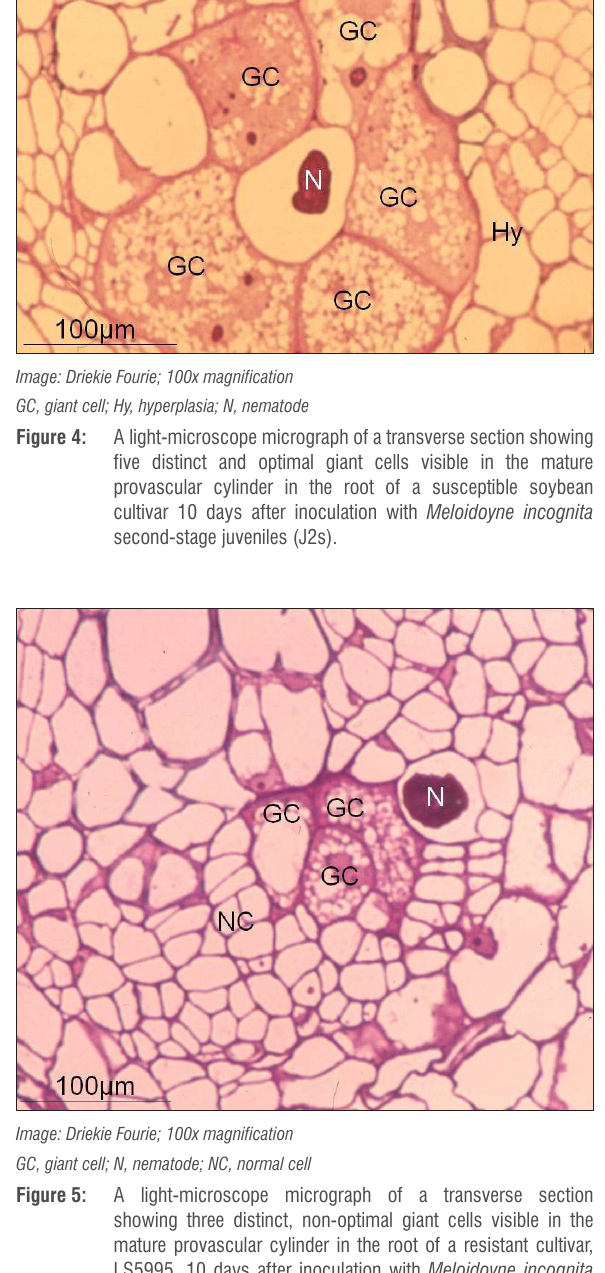
A light-microscope micrograph of a transverse section showing three distinct, non-optimal giant cells visible in the mature provascular cylinder in the root of a resistant cultivar, LS5995, 10 days after inoculation with Meloidoyne incognita second-stage juveniles (J2s).